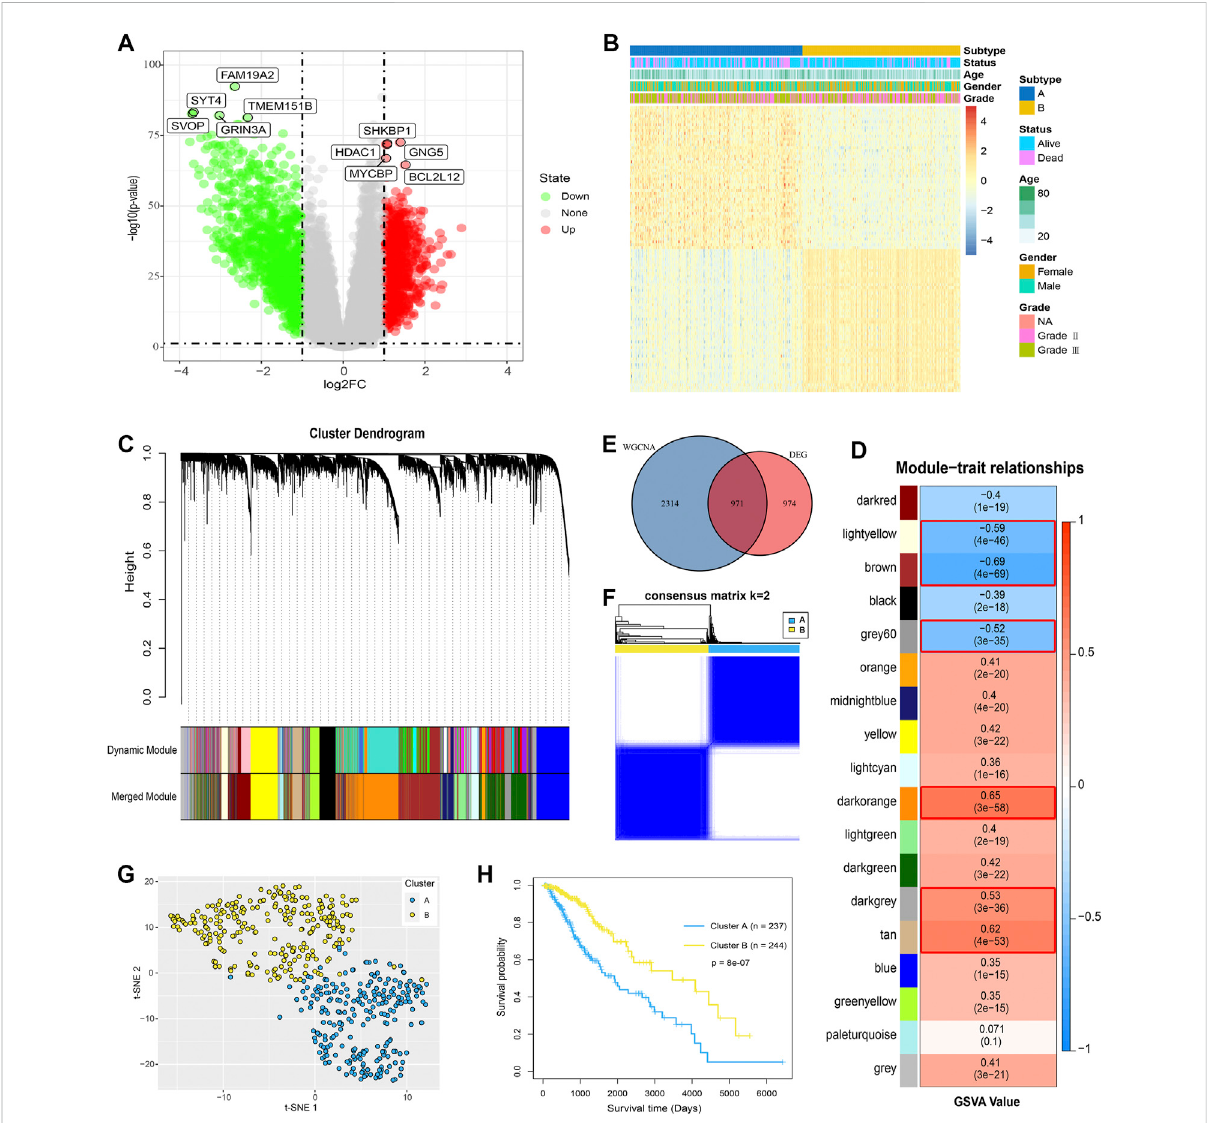
FIGURE 3 Identi fi cationofGRGsandglycosylationclusters. (A) VolcanomapshowedtheDEGsbetweentheglycosylationsubtypes.Red representedup- regulated genes and green represented down-regulated genes. (B) Heat map showed clinical features and top 100 DEGs between glycosylation subtypes. (C) Gene co-expression network and gene modules were identi fi ed by WGCNA. (D) In total, 18 gene modules were recognized, and six modules marked with red frames, with | correlation coef fi cient | > 0.5, were considered as closely related to glycosylation. (E) In total, 971 overlapping genes were determined by DEGs and WGCNA were de fi ned as GRGs. (F) Consensus clustering matrix for k = 2 and (G) t-SNE identi fi ed glycosylation clusters, which were both based on the expression pro fi les of GRGs in the TCGA cohort. (H) K-M analysis for the clusters of LGGs